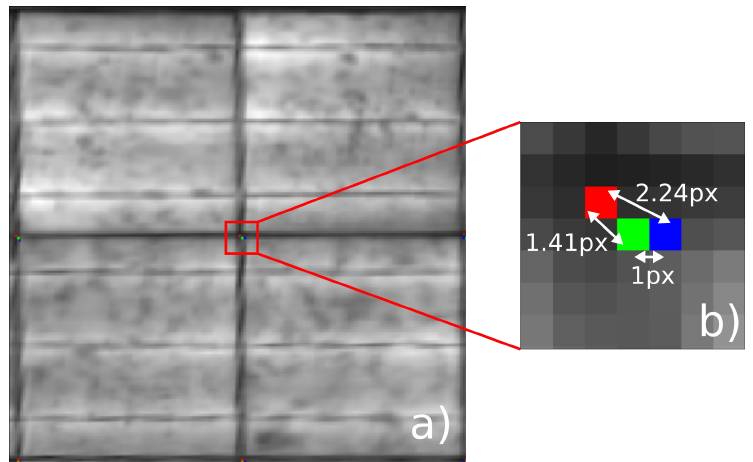
Figure 6. Accuracy measurement. ( a ) Image section (four cells) of a PV module after distortion and perspective correction. ( b ) Zoomed (7 × 7) px section of ( a ). Three cell gap joint (CGJ) grid pattern point types (algorithm detected points, ideal target points, expert labeled points) serve as control pattern for the inaccuracy measurement of the distortion correction and perspective transformation. Assuming all PV cells are the same size and are regularly aligned, the cell gaps (CG) form an equidistant grid of straight horizontal and vertical lines in distortion free and perfect perspective transformed image. The CGJ locations of the grid should also form an equidistant pattern (target control pattern (green)). The pattern detection, distortion correction and perspective transformation have a residual inaccuracy which means that the previously algorithm detected CGJ point locations (blue) (of Section 3.4) and the target locations (green) deviate from each other. The third control pattern (red) is labelled manually by an expert as visually detected in the distortion corrected and perspective transformed image. The Euclidean distance (Equation (16)) between the points showed in ( b ) provides a suitable accuracy metric that shows how they deviate from each other. A Euclidean distance of zero means that the two positions are at the identical pixel location.